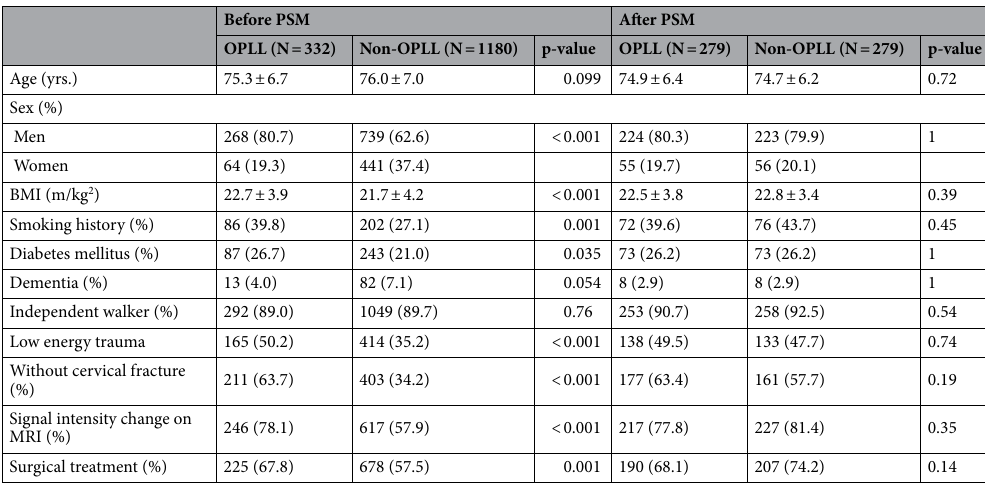
Table 3. A comparison of the demographic data at baseline. PSM, propensity score matching; BMI, body mass index; MRI, magnetic resonance imaging.